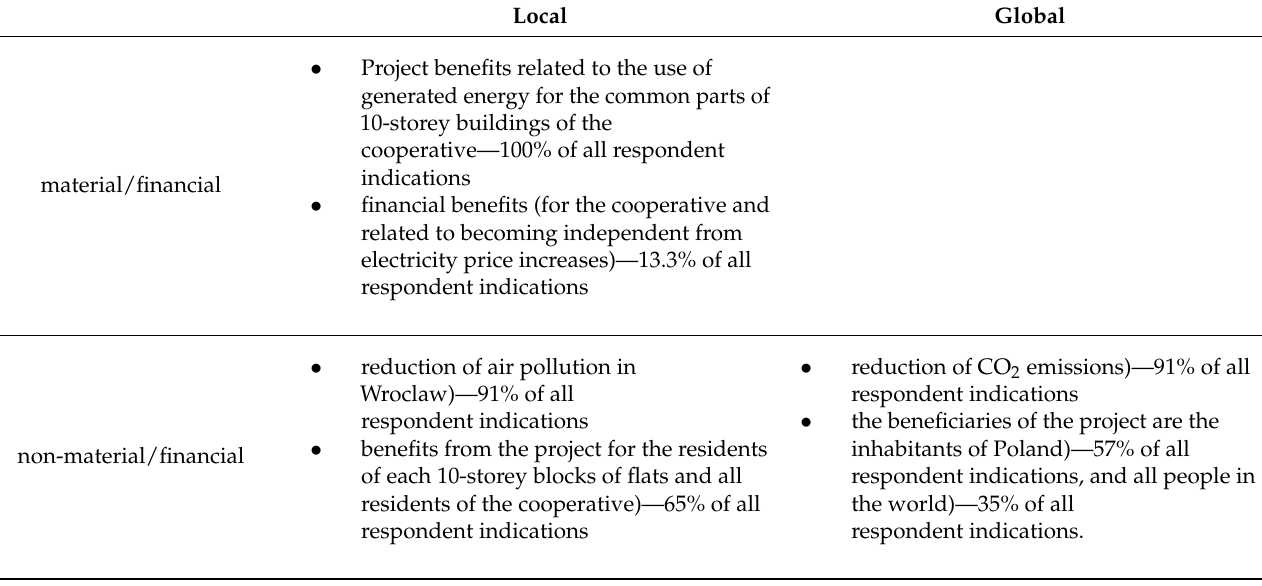
Table 6. Respondent motivation matrix—material–non-material values and local/global values.